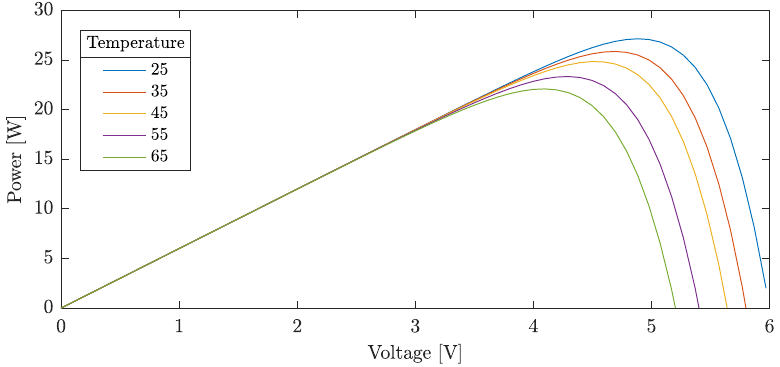
Figure 13. Output power with respect to output voltage for various temperatures.